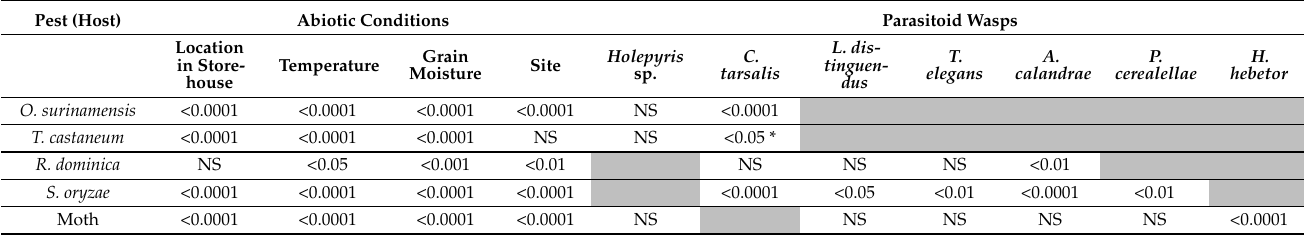
Table 2. The effect of the abundance of dominant parasitoid-wasp species on the abundance of their hosts. Pest (Host) Abiotic Conditions Parasitoid Wasps Location in Store- Temperature Grain Moisture Site Holepyris house